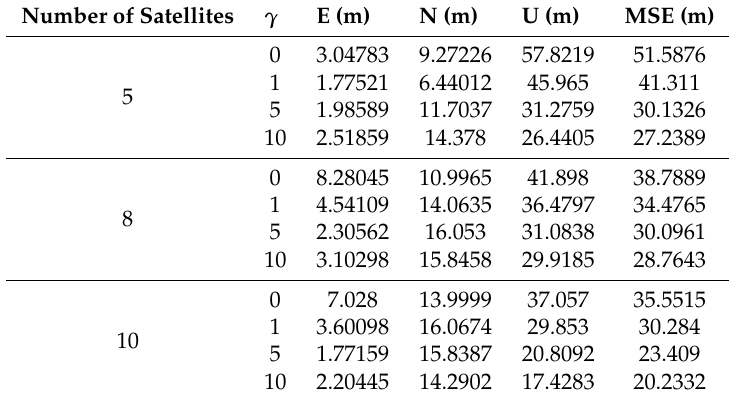
Table 4. Results for the scenario 2 with increasing penalty weight and different number of satellites.